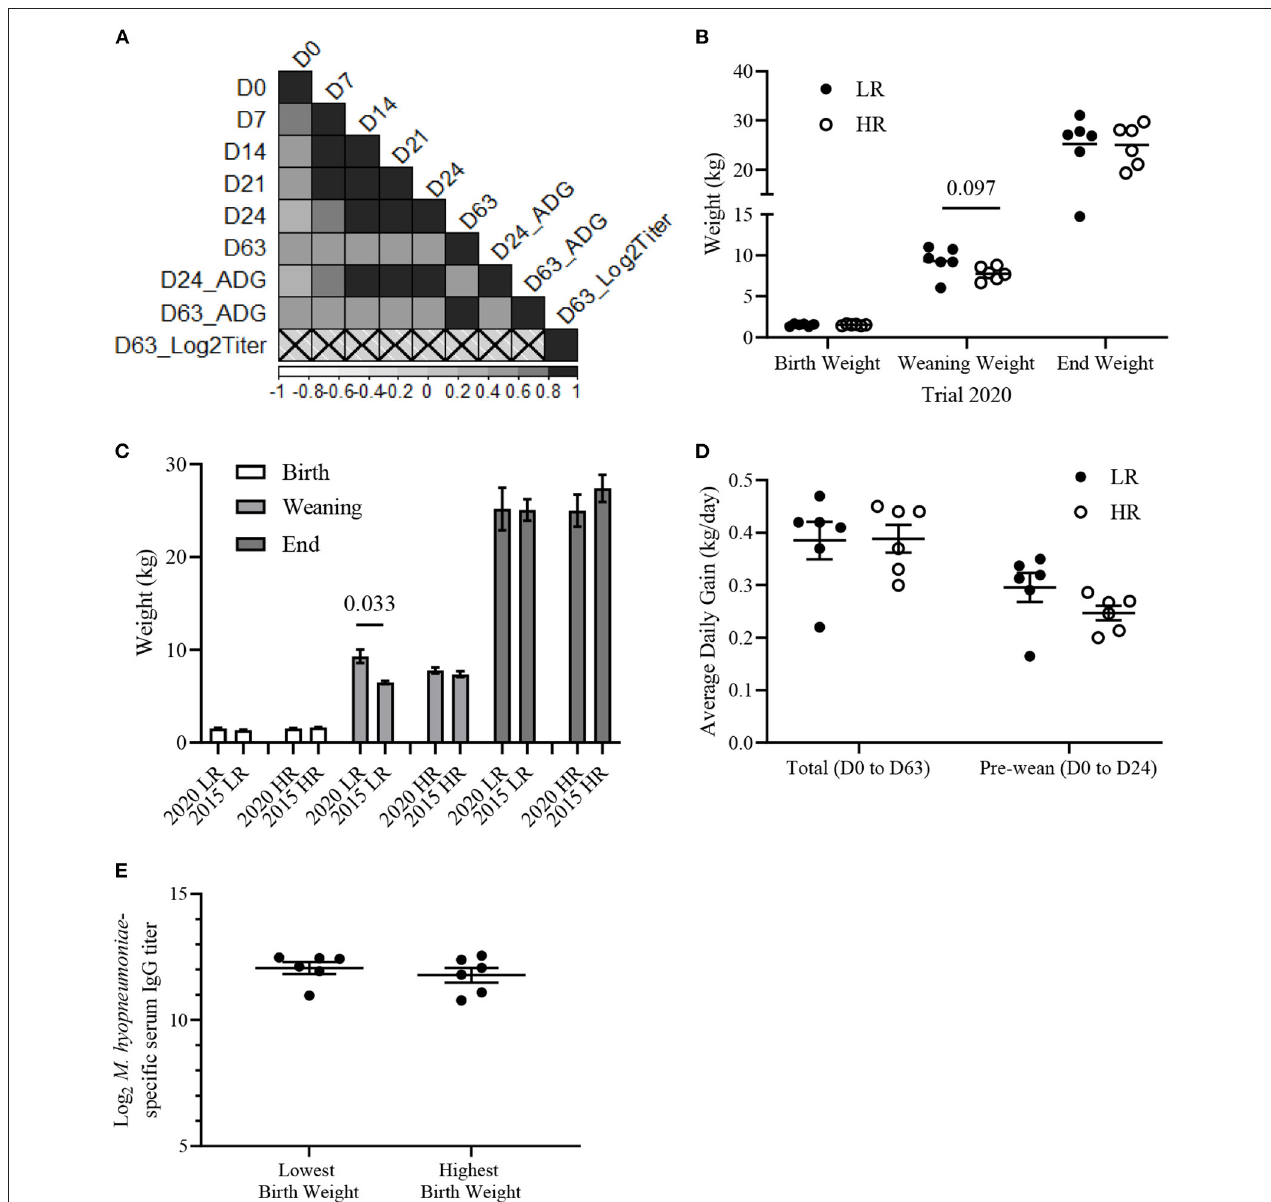
FIGURE 4 | Mycoplasma hyopneumoniae- specific serum IgG titers do not associate with body weights of piglets from Trial 2020. (A) Pearson correlation matrix of body weights at Day 0 (D0), D7, D14, D21, D24, D63, pre-weaning average daily gain (D24_ADG), total average daily gain (D63_ADG) and Log 2 M. hyopneumoniae -specific serum IgG titer (D63_Log2Titer) from Trial 2020 ( n = 67). Scale represents Pearson coefficients. Crosses designate insignificant ( p > 0.05) correlations. (B) Mean ( ± SEM) body weight (kg) of low (LR; n = 6; filled circles) and high (HR; n = 6; empty circles) at birth (D0), weaning (D24), and 63-days of age (D63). (C) Mean ( ± SEM) body weight (kg) of LR and HR from Trial 2020 and Trial 2015 on D0, D24, and D63. (D) Mean ( ± SEM) average daily gain (kg/day) of LR and HR from Trial 2020 from birth to the end of trial (D0–D60) and from birth to weaning (D0–D24). Average daily gain = [Body weight (kg)—Birth weight (kg)]/age in days (days). (E) Mean ( ± SEM) Log 2 M. hyopneumoniae -specific serum IgG titer of piglets with the lowest ( n = 6) and highest ( n = 6) weight at D0. Differences between groups determined using a two-tailed, unpaired Student’s t -test with Welch’s correction.